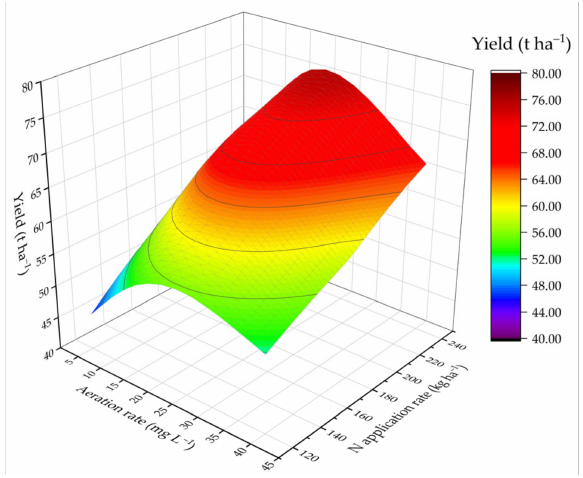
Figure 1. Yield response curved surface of tomato under fertilizer-air coupled irrigation in 2019. From Figure 1, it was indicated that the parameters A, B and C of the water sensitivity index accumulation curve were 2.641, 0.041 and 0.693 respectively. The water sensitivity index of tomato in different growth stages ranked in descending order: flowering